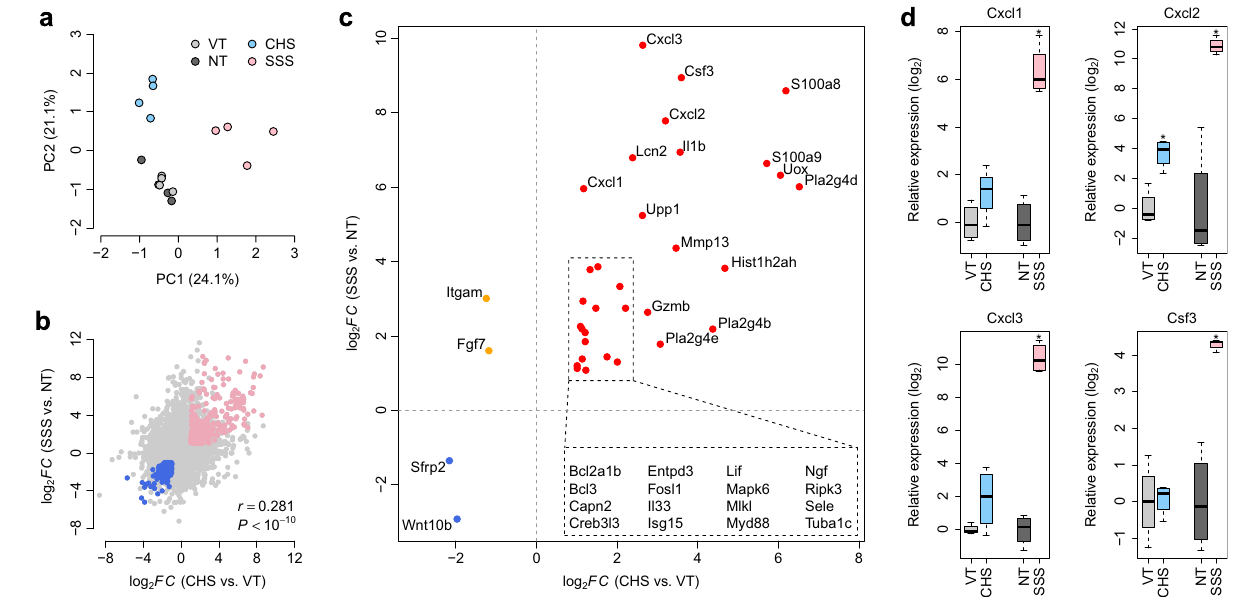
Figure 1. Differential gene expression in contact hypersensitivity (CHS) and skin-scratching stimulation (SSS) murine models. ( a ) Principal component analysis of whole-genome expression. ( b ) Correlation of log 2 - transformed gene expression fold-changes (log 2 FC) between the CHS and vehicle control (VT) groups (X-axis), and SSS and non-treated control (NT) groups (Y-axis). Pink/blue dots denote genes commonly upregulated/ downregulated in CHS and SSS samples relative to their expression in the VT and NT samples, respectively. ( c ) Top dysregulated genes within prioritized Kyoto Encyclopedia of Genes and Genomes pathways. X-axis: log 2 FC values between the CHS and VT groups; Y-axis: log 2 FC values between the SSS and NT groups. Red/blue dots denote genes commonly upregulated/downregulated in both murine models, and the orange dots denote genes dysregulated in opposite directions. ( d ) qPCR validation of selected genes. *Indicates the statistical significance at P <